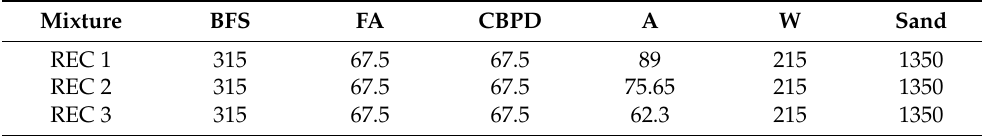
Table 4. Reception of the raw material values is given in